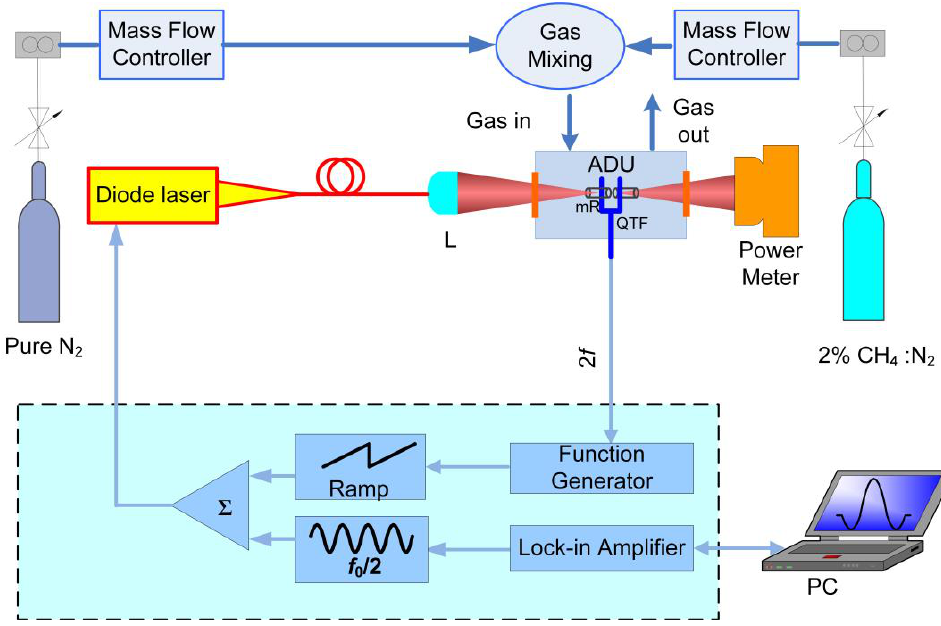
Figure 5. Schematic diagram of CH 4 -QEPAS sensor with 3D-printed ADU.